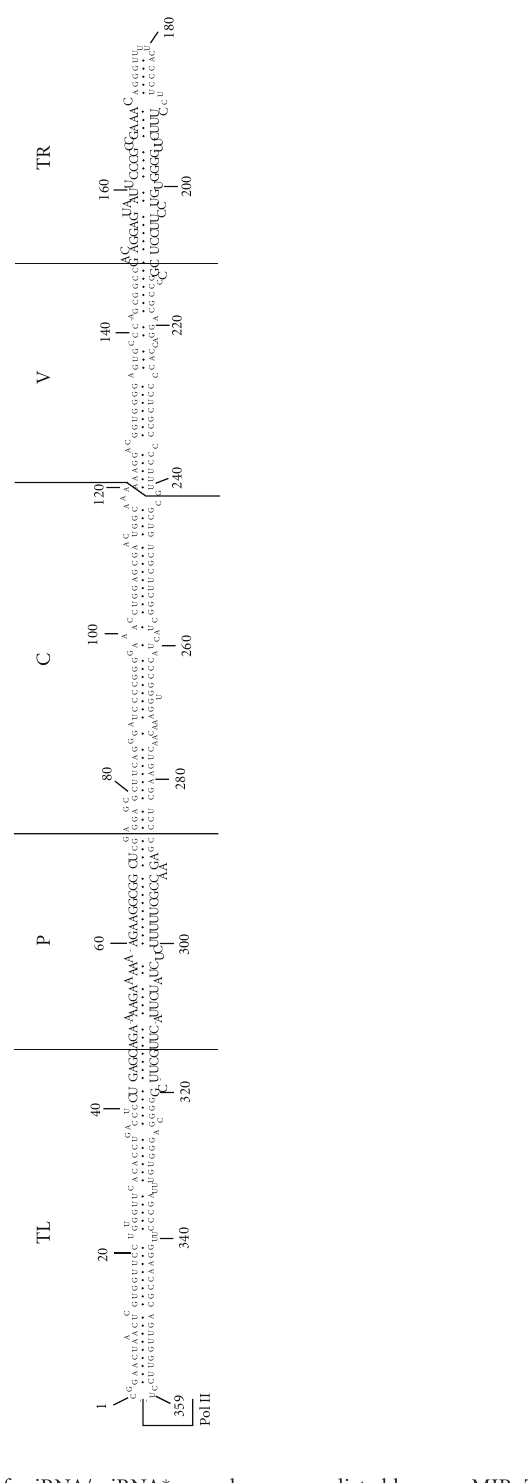
Figure 4: Secondary structure of PSTVd and location of miRNA/miRNA ∗ complexes as predicted by novoMIR . The structure scheme is based on a consensus structure of 45 (+)-stranded circular PSTVd sequence variants [32]; the sequence is given for the PSTVd variant Intermediate [33]. The five homology domains of pospiviroids are marked as proposed by Keese and Symons [34]: terminal left and right (TL,TR), pathogenicity-modulating (P), central conserved (C), and variable (V) domain. The transcription start site for ( − )-strand synthesis is marked by “polII” [35]. The predicted miRNA/miRNA ∗ complexes are shown as larger italic characters. The complex in the P domain is predicted using default parameters; the complex in the TR domain is additionally predicted with a normalized energy threshold t Δ G/L/f 0 . 69 (instead of